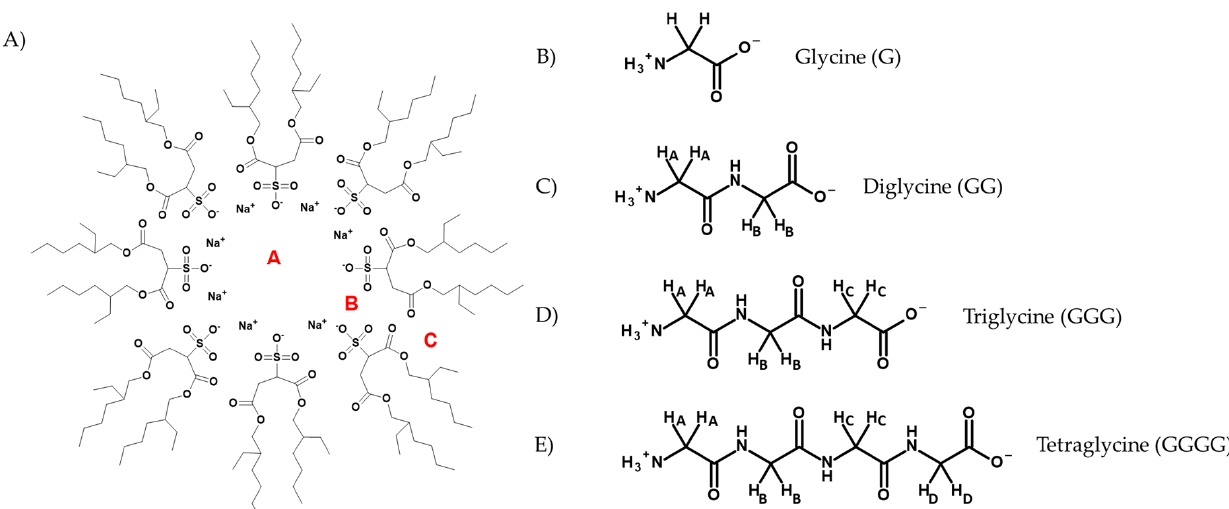
Figure 1. The structure of glycine (G) analogs and schematic of the Aerosol-OT reverse micelle (AOT RM) model system. ( A ) A schematic of a simplified structure of an RM. “A” represents the bulk water pool, “B” is the interfacial region of the RM in the region of the charged AOT head groups, and “C” represents association in the more hydrophobic region of the RM in the region of the acyl groups, hydrophobic tails, and isooctane solvent. ( B ) The amino acid G at physiological pH. ( C ) Structure of diglycine (GG), with protons labeled corresponding to proton peaks analyzed by 1 H NMR ( D ) Structure of triglycine (GGG) with protons labeled corresponding to proton peaks analyzed via 1 H NMR. ( E ) Structure of tetraglycine (GGGG), with protons labeled corresponding to proton peaks analyzed via 1 H NMR.